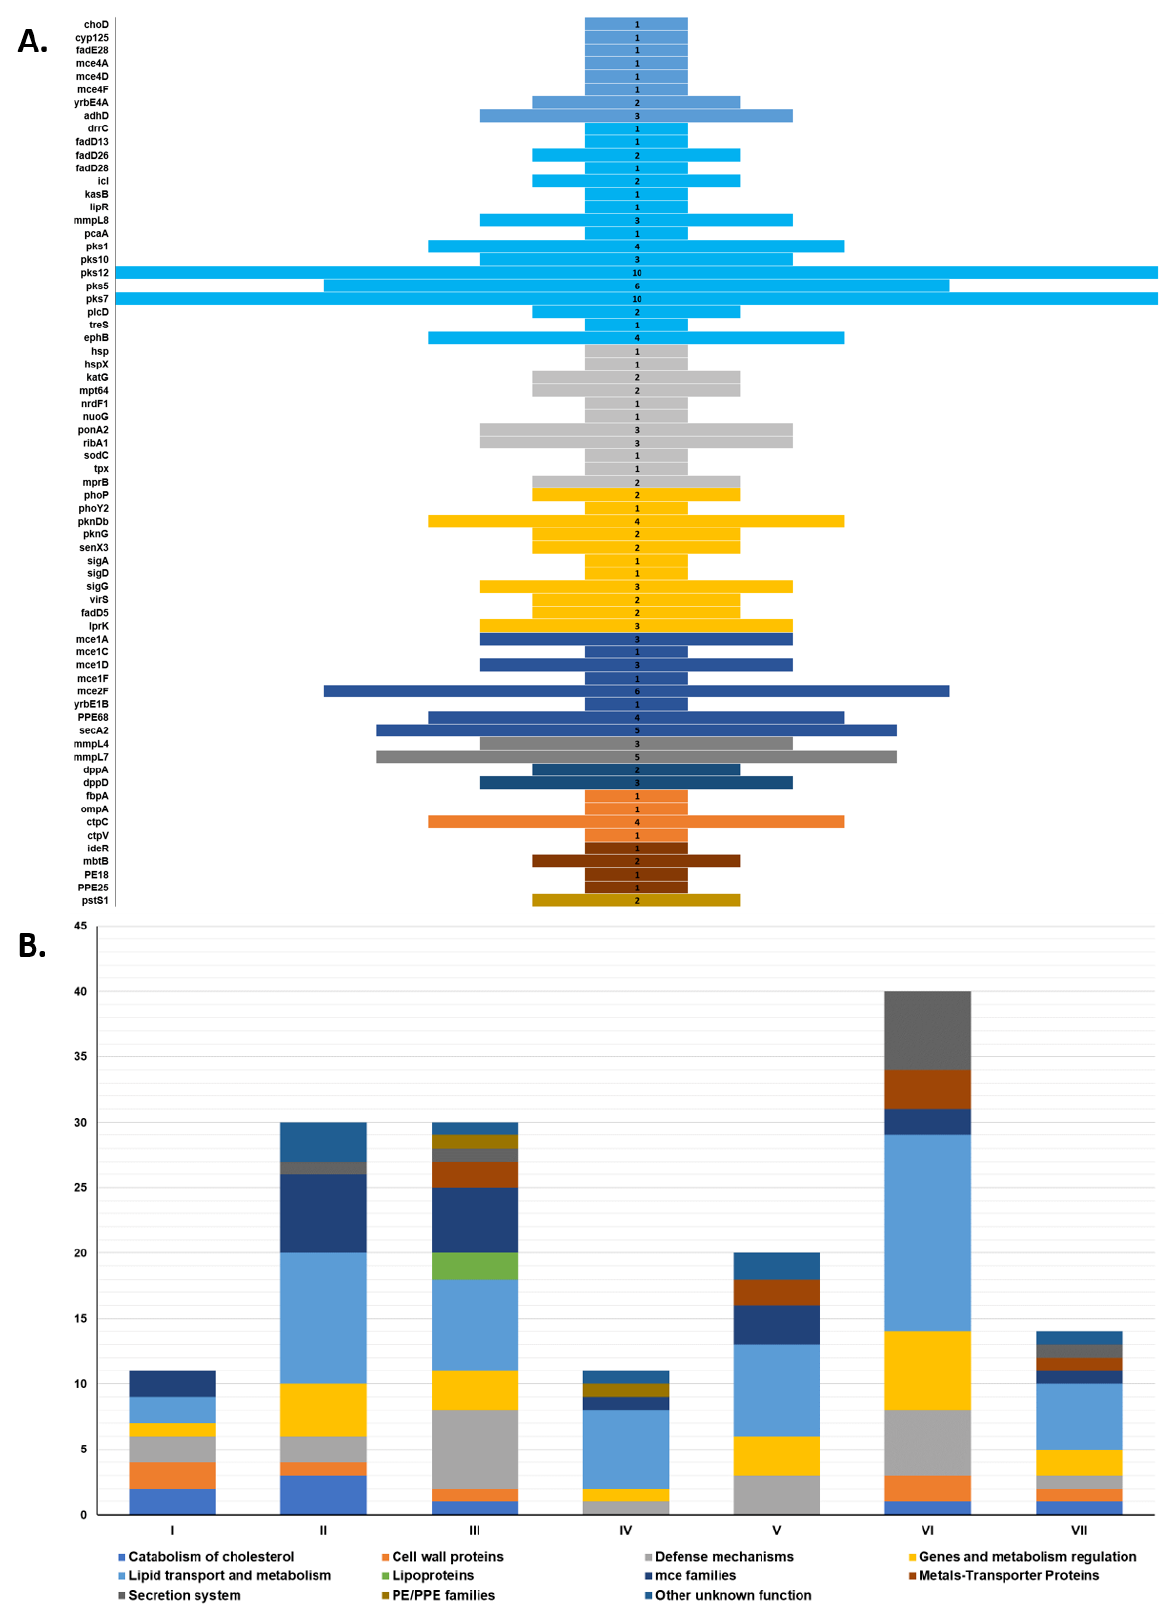
Figure 5. Distribution of virulence-associated SNPs. ( A ) Frequency of SNP-hits among 68 virulence genes; ( B ) within-clade distribution of SNPs according to functional class. A more detailed list of all the SNPs associated with virulence genes can be consulted in Supplementary File